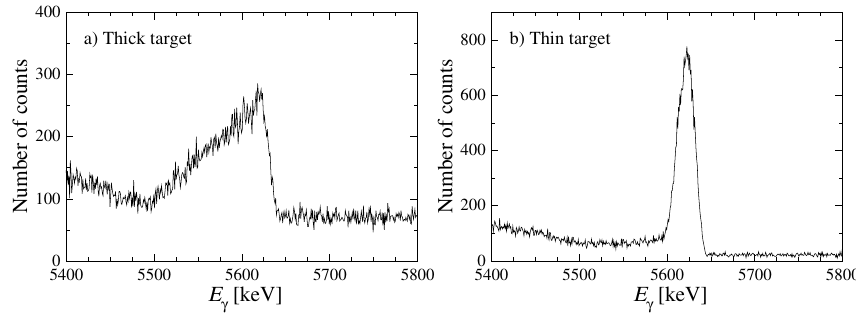
Figure 1. Full-energy peak in the γ -ray spectra from the 2 H(p, γ ) 3 He reaction, measured at θ = 135 ◦ with the proton beam of E p = 260